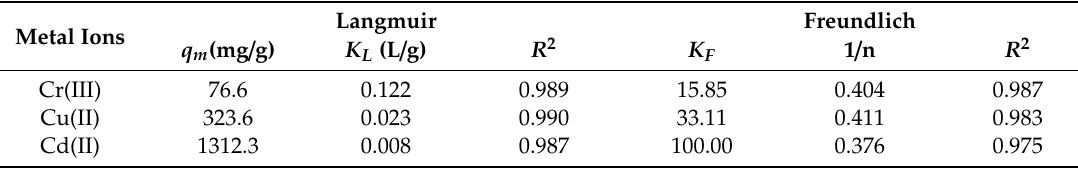
Table 2. Adsorption isotherm parameters for the removal of Cr(III), Cu(II), and Cd(II) ions by the